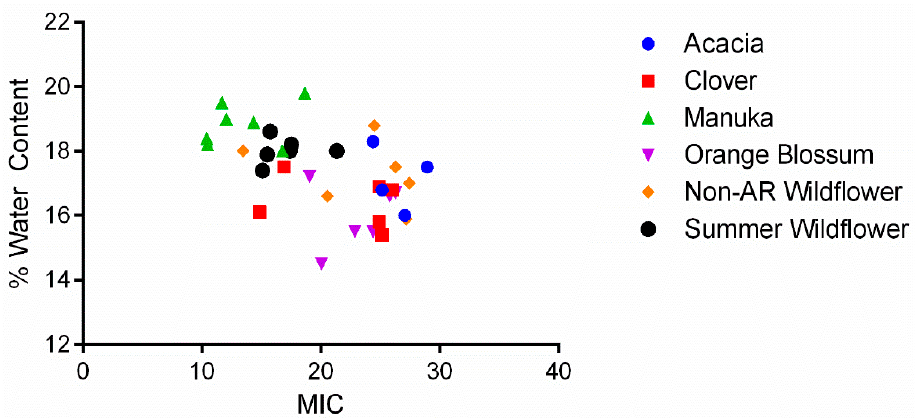
Figure 4. Relationship between a honey’s water content and average MIC against all species tested. There is a significant inverse trend, indicating that a higher water content corresponds to a higher efficacy (lower MIC) (Pearson’s R = − 0.543, p < 0.0008, n =